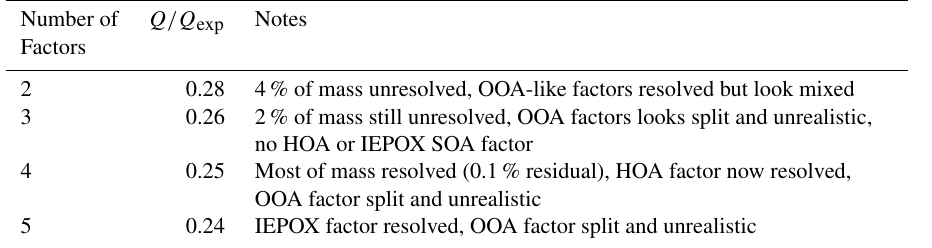
Table A1. Summary of scaled residuals and reasoning used in the choice of a five-factor solution in the PMF analysis of the wet-season HR-AMS